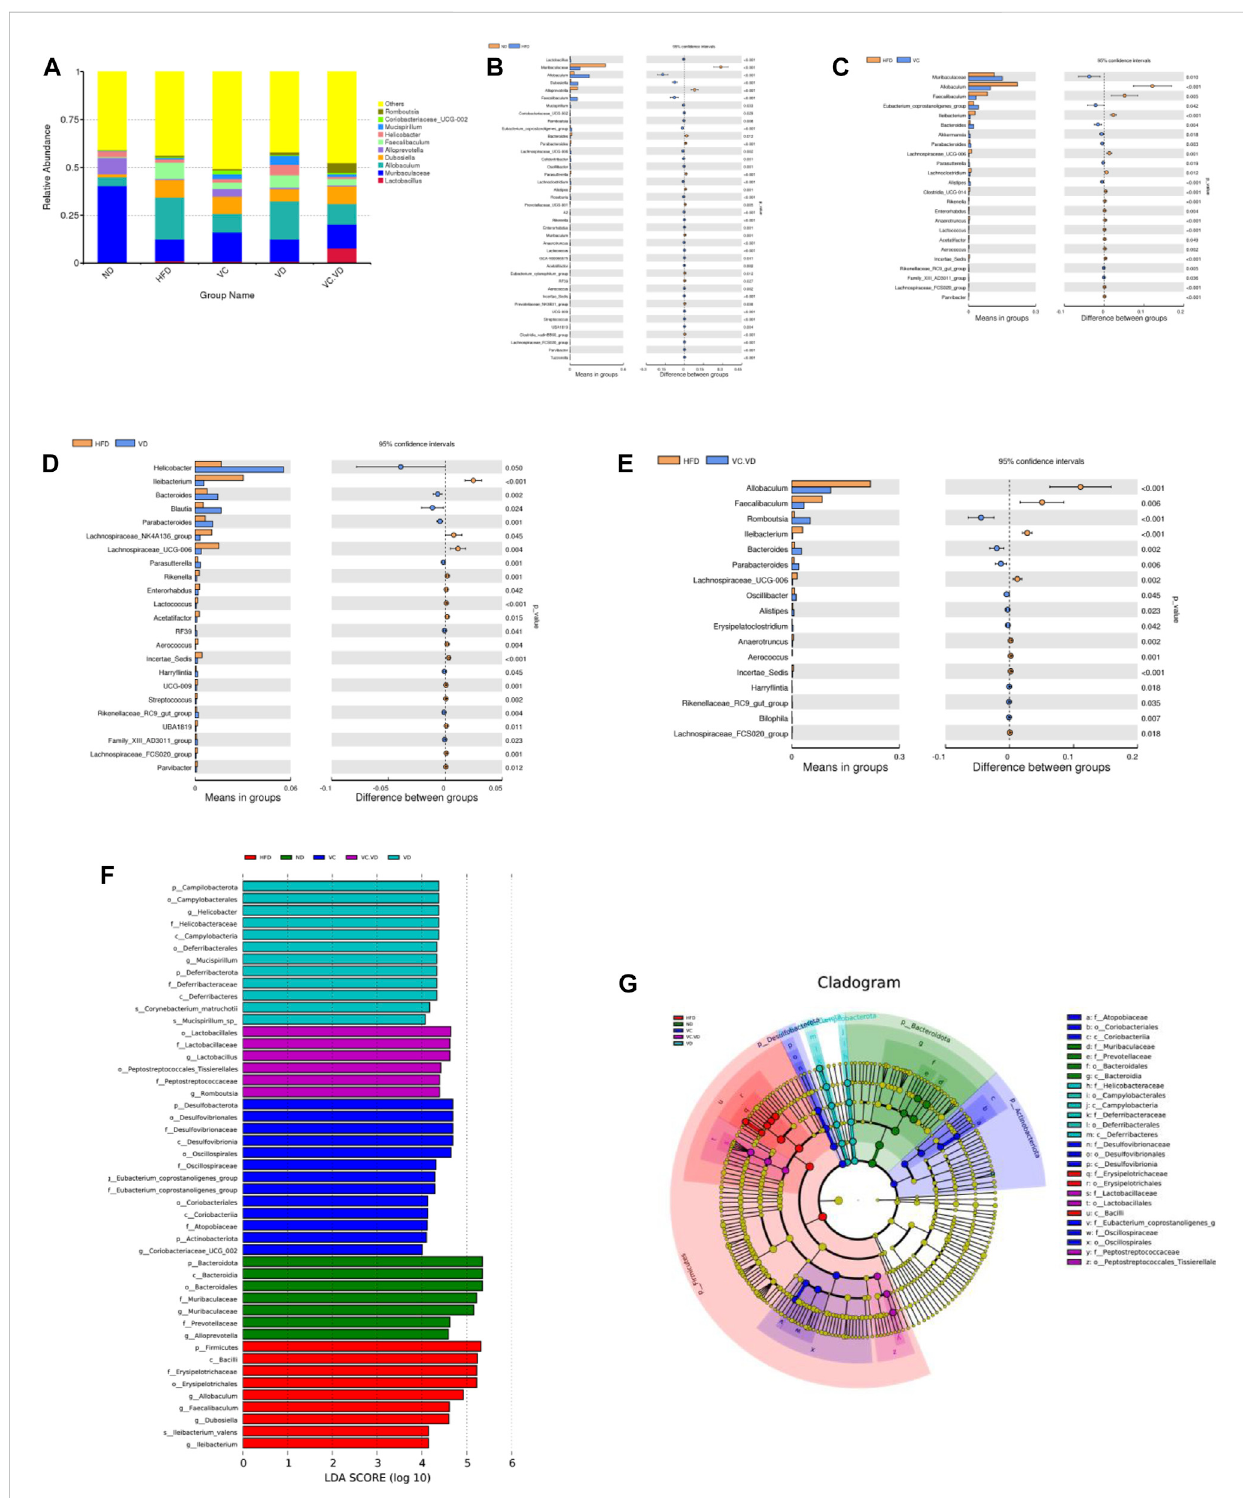
FIGURE 3 VC and VD 3 improved the gut microbiota in obese mice. (A) Relative abundances at the genus level. (B – E) Discrepancy in the gut microbiota composition between groups at the genus level. Species with signi fi cant differences between the ND and HFD groups (B) , HFD and VC groups (C) , HFD and VD groups (D) , and HFD and VC + VD groups (E) were analyzed. A signi fi cant discrepancy was de fi ned as p < 0.05 according to the t -test. (F) LEfSe analysis of the dominant biomarker taxa among the fi ve groups. The threshold of the logarithmic score of LDA was 4.0. (G) Taxonomic cladogram obtained from LEfSe analysis by comparing the 5 groups. ( n = 12